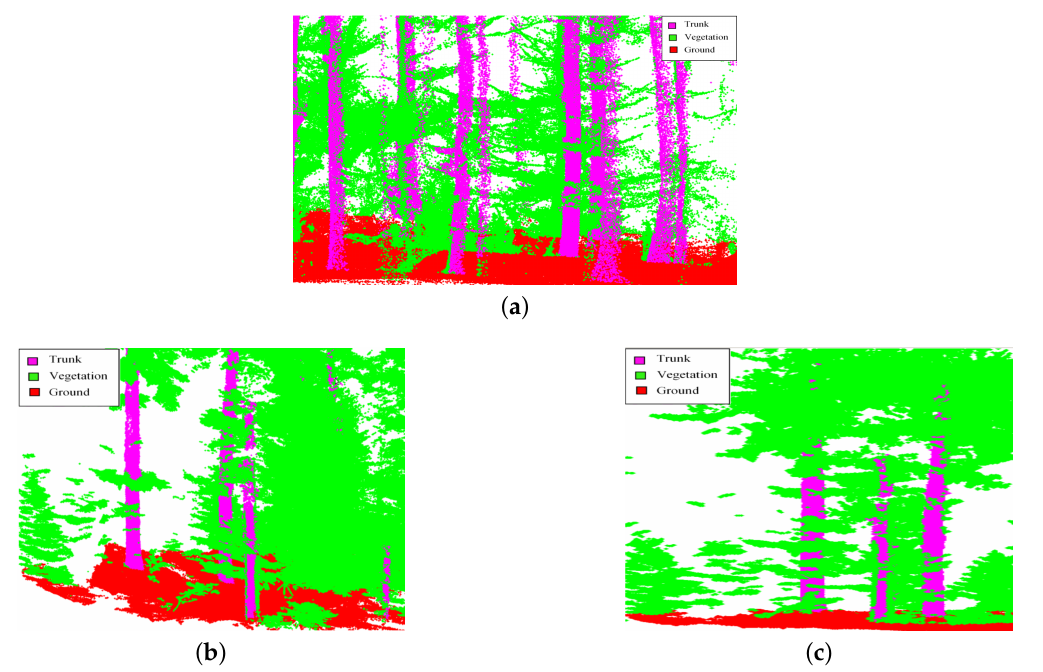
Figure 13. ( a – c ) present some segmentation and classification results for trees from a silver fir ( Abies alba Mill.) tree forest in the Auvergne-Rhone-Alpes region (département du Puy-de-Dôme) of Central France using a static terrestrial scanning system